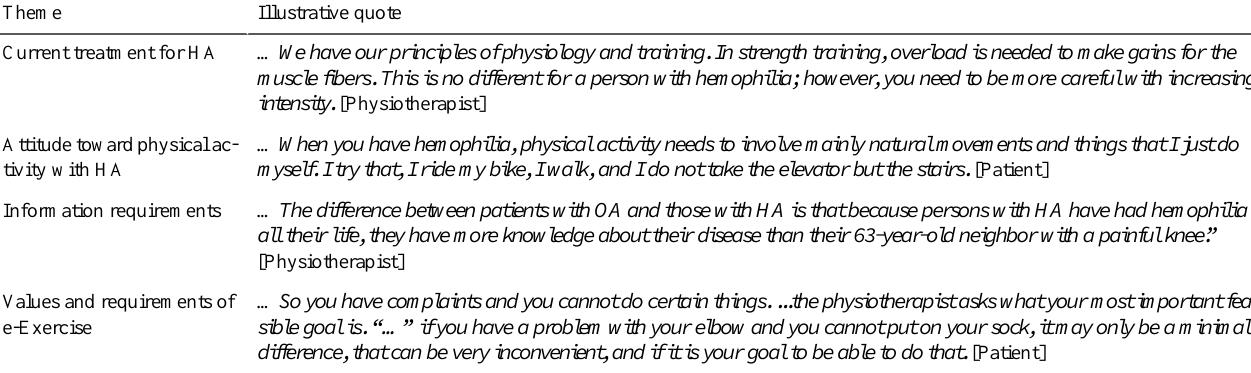
Table 3. Quotes from physiotherapists and persons with HA a . Illustrative